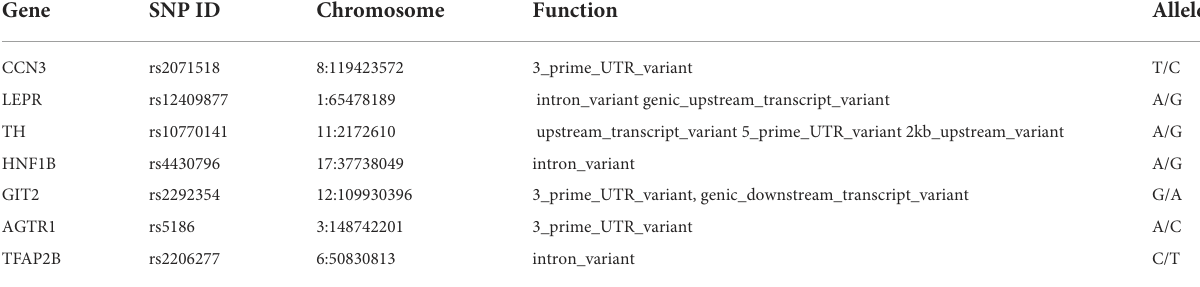
TABLE 2 The SNPs analyzed in this sub-analysis. Gene